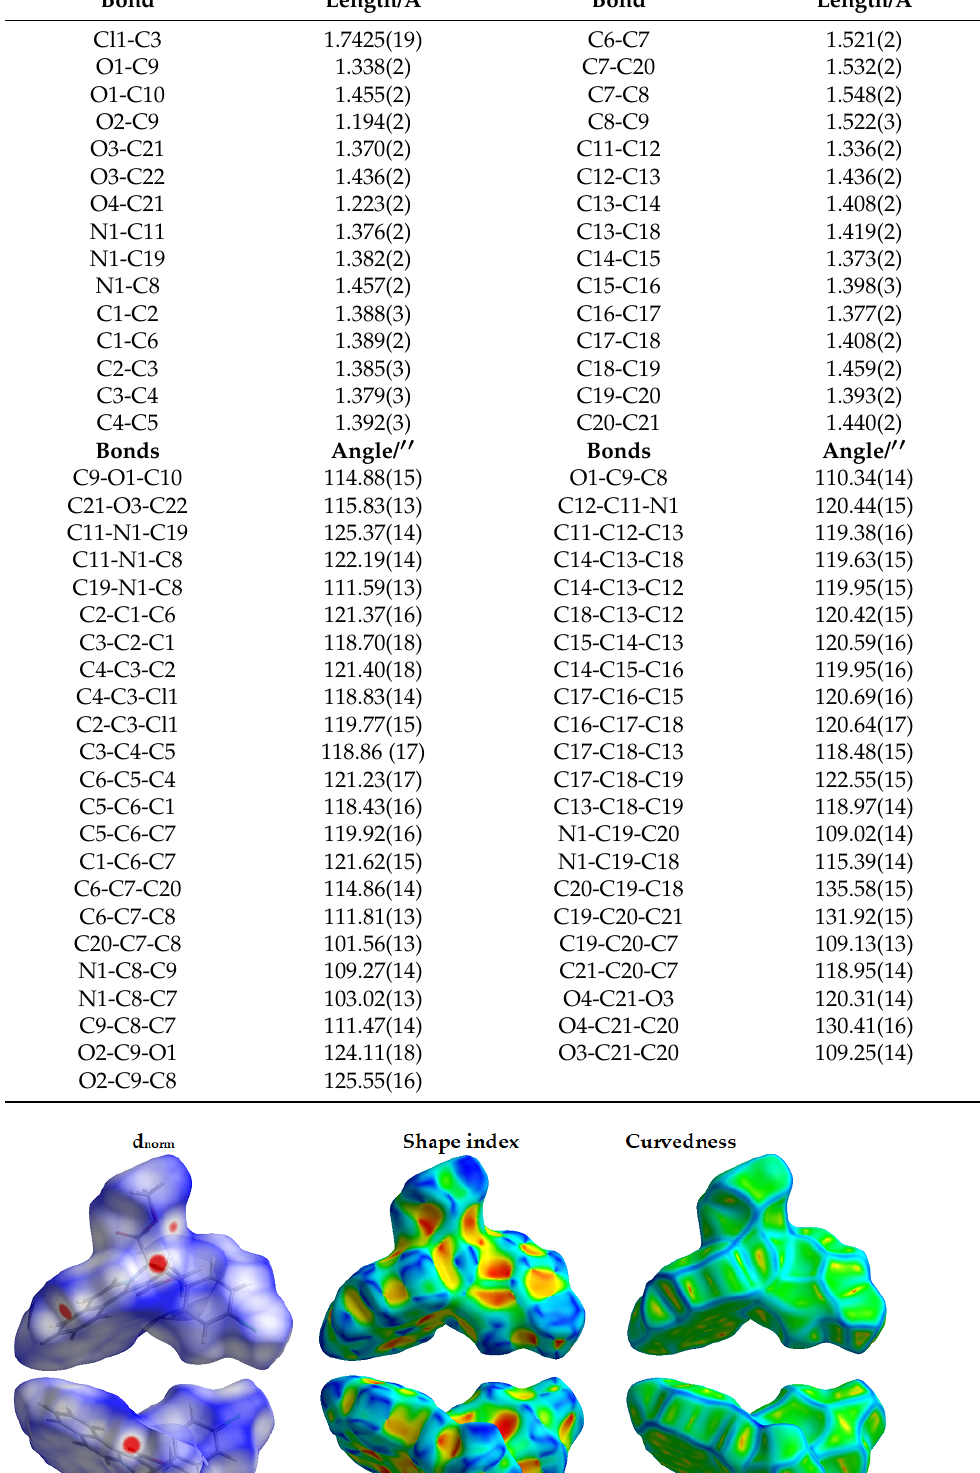
Table 2. Bond lengths (Å) and angles ( ◦ ) for 3 .